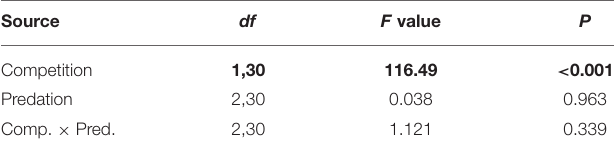
TABLE 2 | ANOVA results for time to eclosion of cohorts of female Aedes aegypti . Source df F value